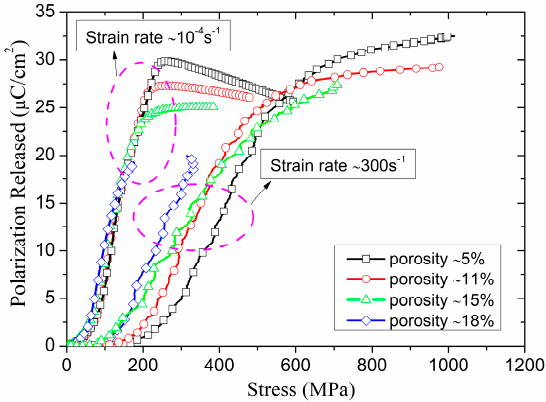
σ and σ versus porosity. D P